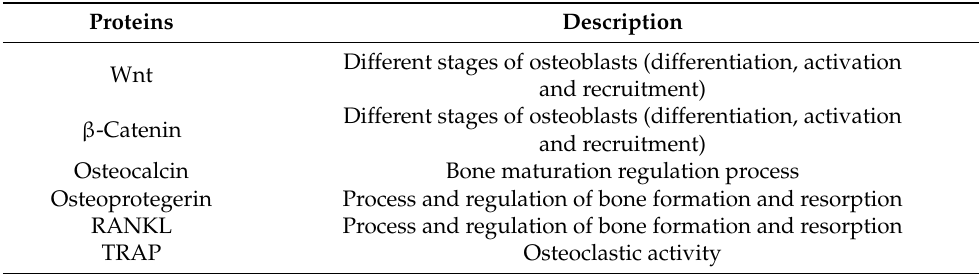
Figure 5. Immunohistochemical analysis of SHAM and ORQ groups (BG and BG-PTH) through protein labeling: Wnt, Bcat, OC, OPG, RANKL and TRAP. Labeling indicated by red arrows, (Original, 20 × ). Table 5. Brief description of proteins Wnt, β -Catenin, osteocalcin, osteoprotegerin, RANKL and